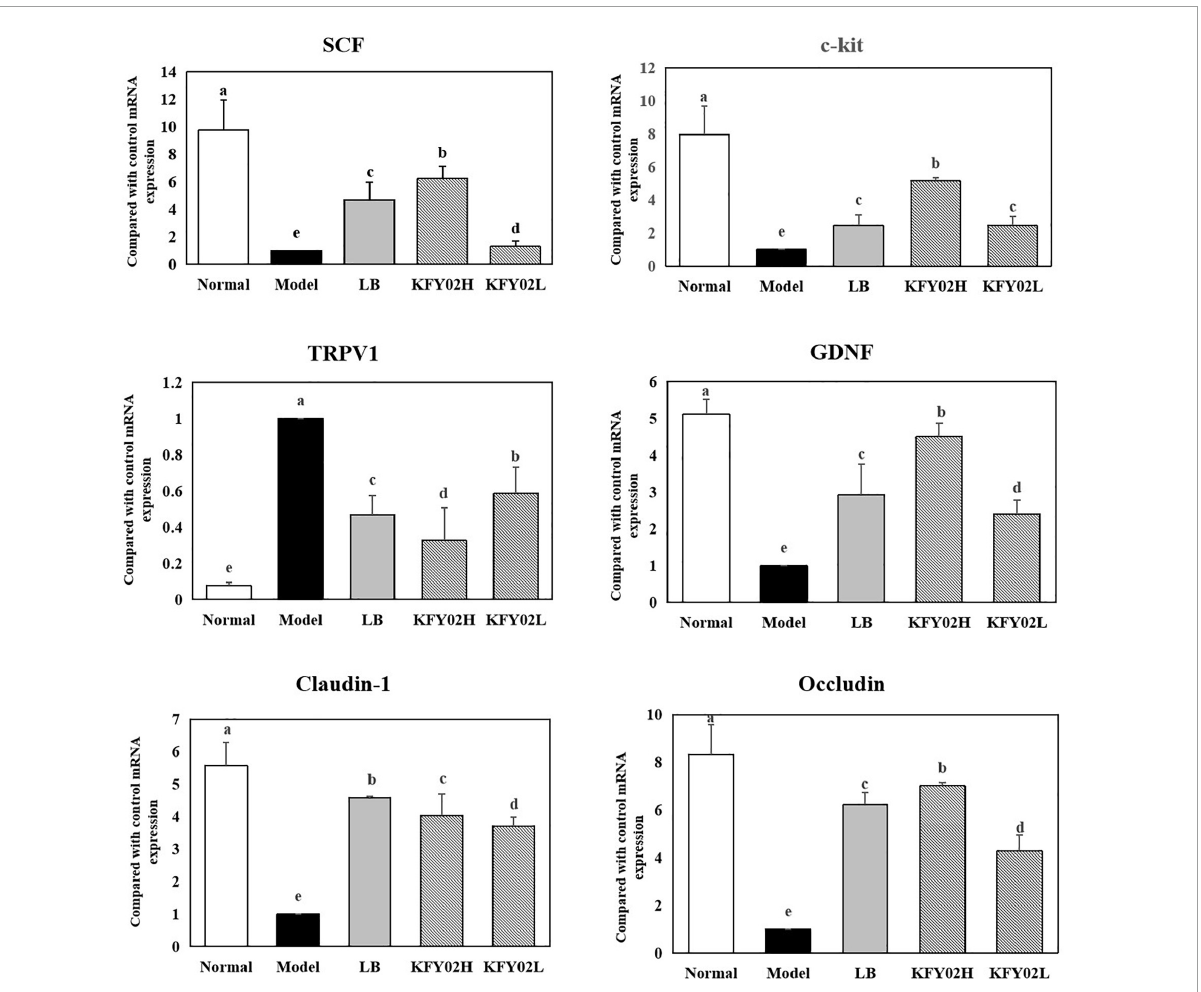
FIGURE6 mRNA expression levels of SCF, c-kit, TRPV1, GDNF, claudin-1, and occludin in the mice colon tissues. Data are means ± standard deviations. a - e Different superscript letters within a column correspond to significant differences ( p < 0.05). LB: mice administered with 1 × 109 CFU/kg LB, KFY02H: mice administered with 1 × 109 CFU/kg LP-KFY02, KFY02L: mice administered with 1 × 108 CFU/kg